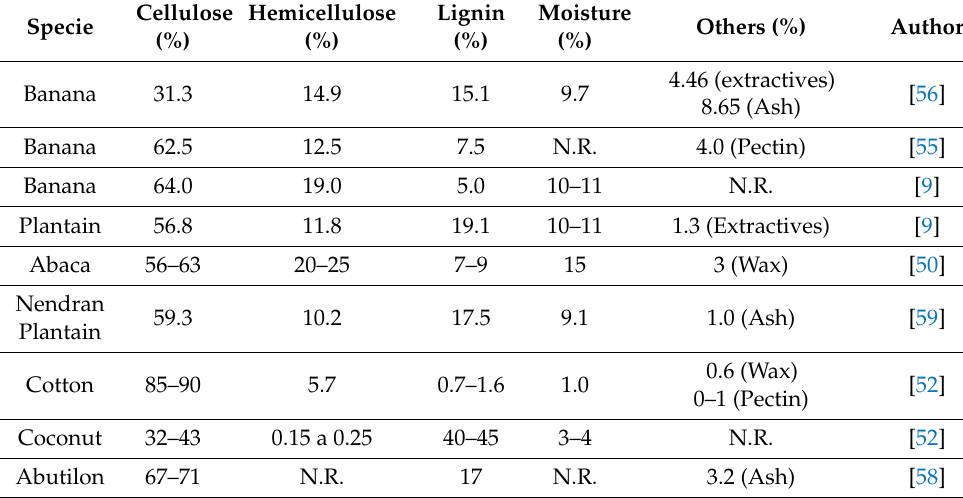
Table 2. Chemical composition of different sources of lignocellulosic fibres.